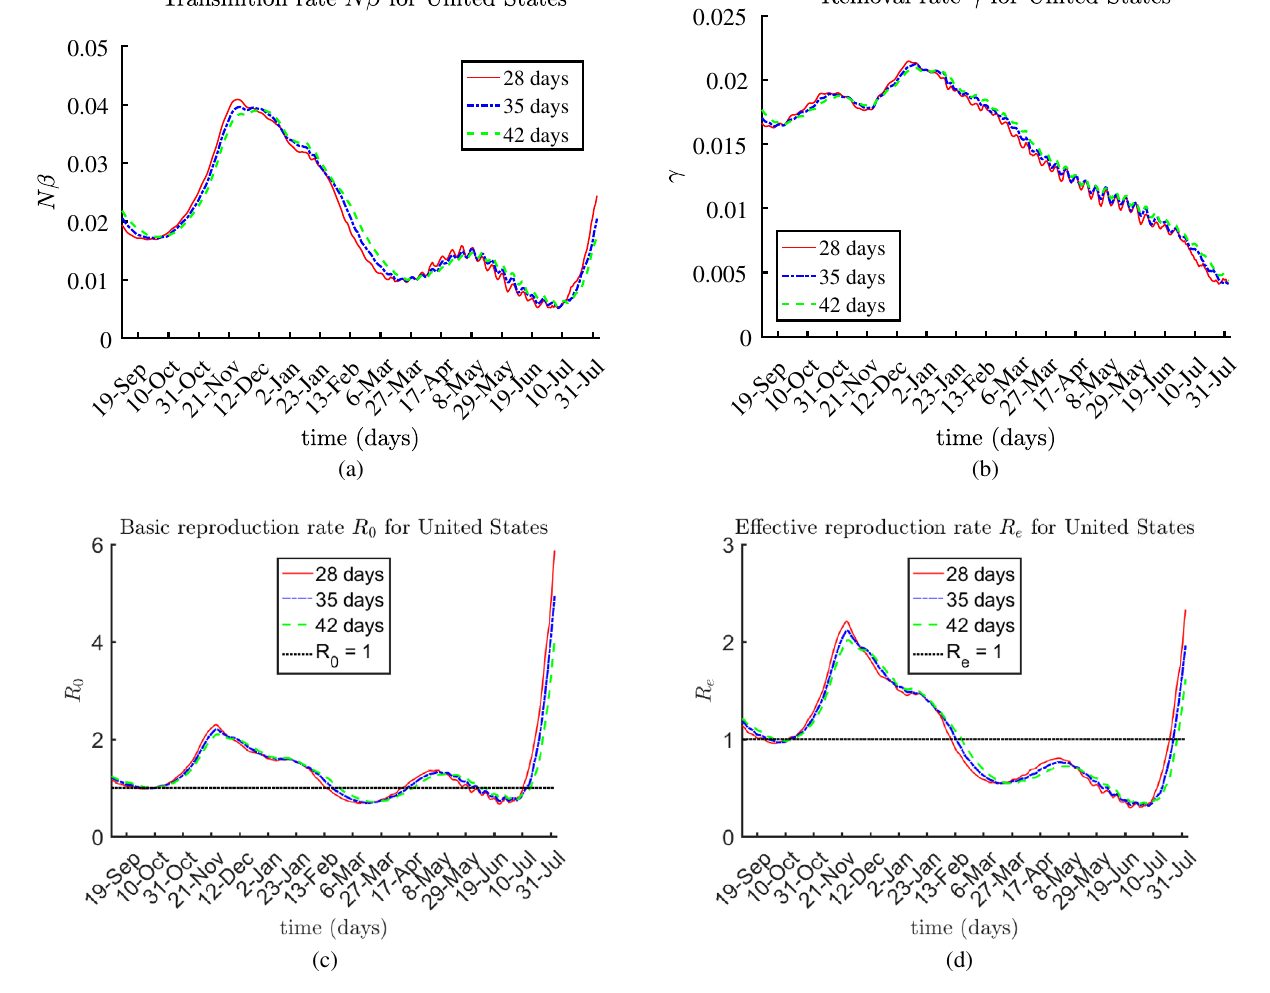
Figure 6. Estimated rates N β , γ , R 0 , and R e for United